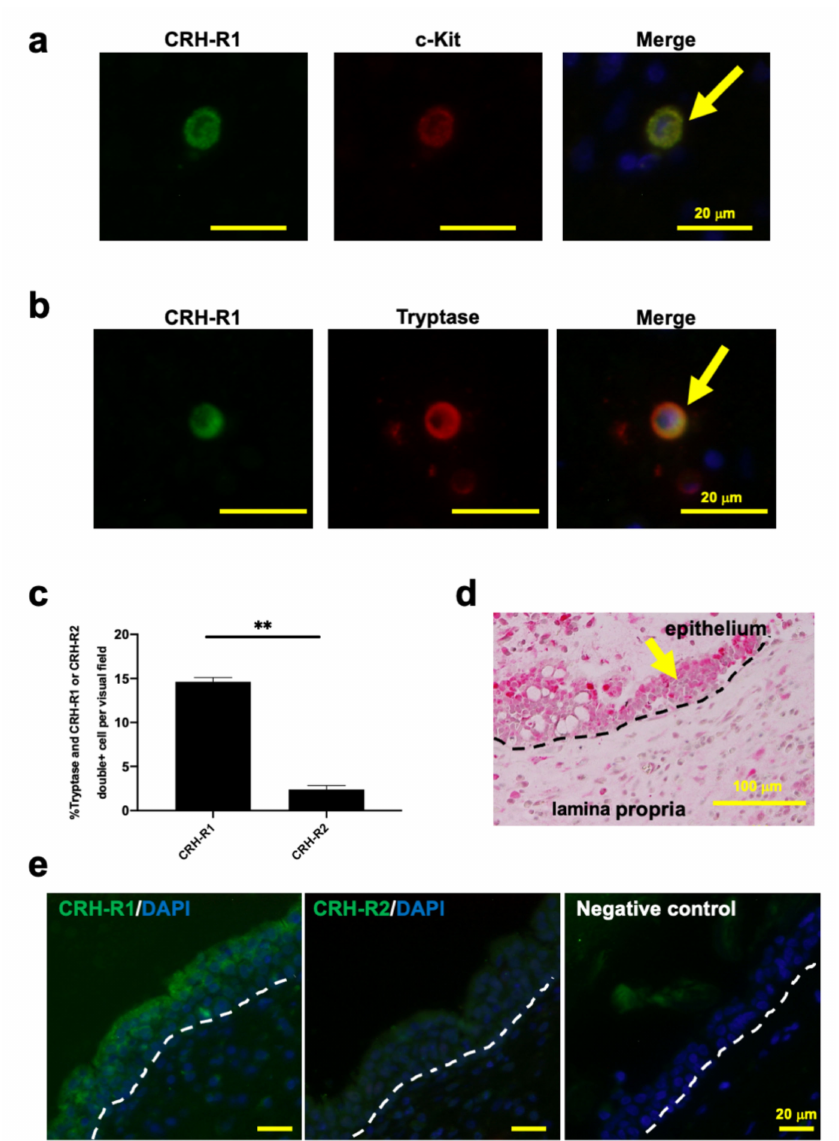
Figure 1. Human nasal mucosa mast cells (hM-MCs) and the mucosal epithelium in nasal polyps (NPs) express corticotropin-releasing hormone receptor type 1 (CRH-R1). ( a ) CRH-R1 expression on c-Kit+ or ( b ) tryptase+ hM-MCs in situ. An arrow denotes double+ MCs. ( c ) Percentage of tryptase and CRH-R1 or corticotropin-releasing hormone receptor type 2 (CRH-R2) double+ MCs. n = 5. ( d ) CRH expression within the mucosal epithelium in NPs (an arrow). ( e ) CRH-R1 and CRH-R2 expression within the mucosal epithelium in NPs. Scale bar = 20 µ m. Error bars indicate the standard error of the mean (SEM). ** p < 0.01. MC, mast cell; hM-MCs, human nasal mucosa MCs; NPs, nasal polyps; CRH, corticotropin-releasing hormone; CRH-R1, CRH receptor type 1; CRH-R2, CRH receptor type 2; DAPI,